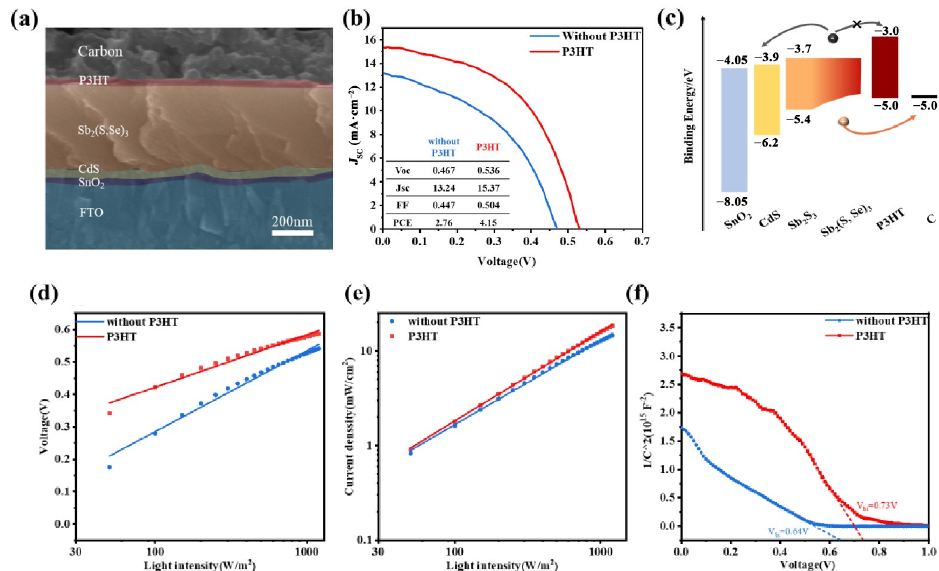
Figure 6. ( a ) Cross-sectional SEM image of the solar cell with P3HT. ( b ) J–V curves of the solar cells with and without P3HT. ( c ) Energy level diagrams of solar cells with a structure of SnO 2 /CdS/Sb 2 S 3 /Sb 2 (S, Se) 3 /P3HT/carbon. Dependence of ( d ) V OC and ( e ) J SC under a different light intensity of the solar cells with and without P3HT. ( f ) Mott-Schottky plots were obtained at 10 kHz of the solar cells with and without P3HT.